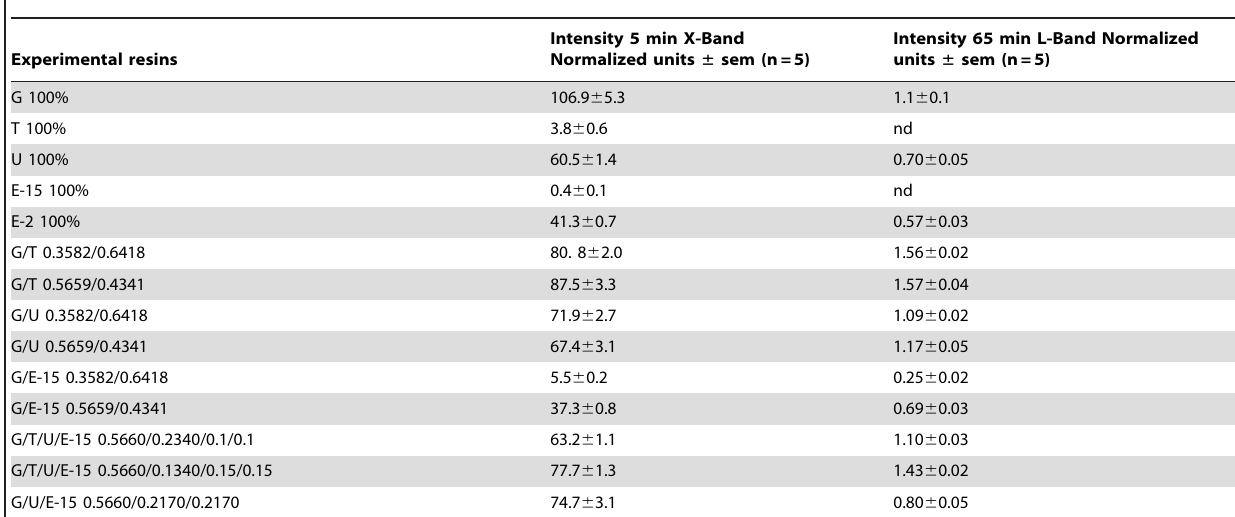
Table 4. Normalized intensities of EPR signal recorded in experimental resins 5 minutes after polymerization (X-band) and 65 minutes after polymerization (L-band). Units are normalized to the signal intensity of dpph.